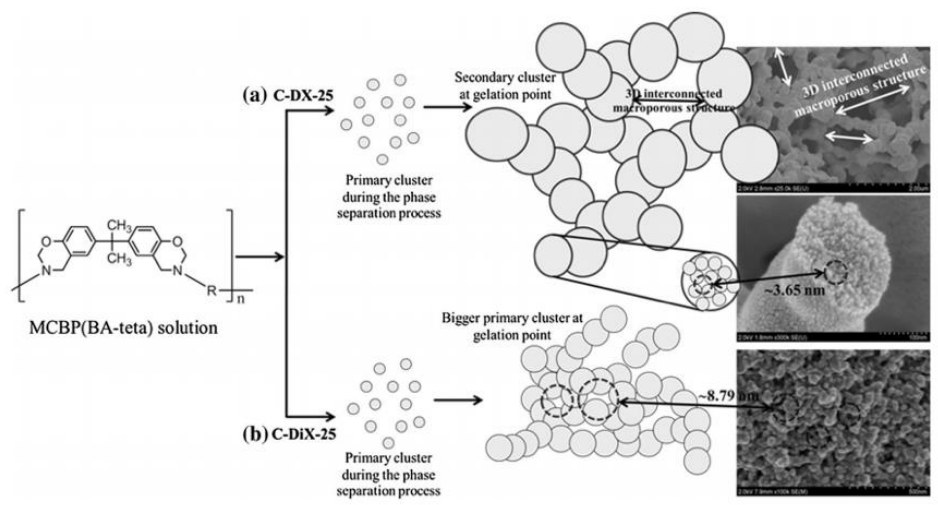
Figure 21. Phase separation of MCBP(BA-teta) solution to form secondary ( a ) and large primary ( b ) clusters and resulting scanning electron microscope (SEM) images of their morphology (reproduced from the work in [34] with permission).